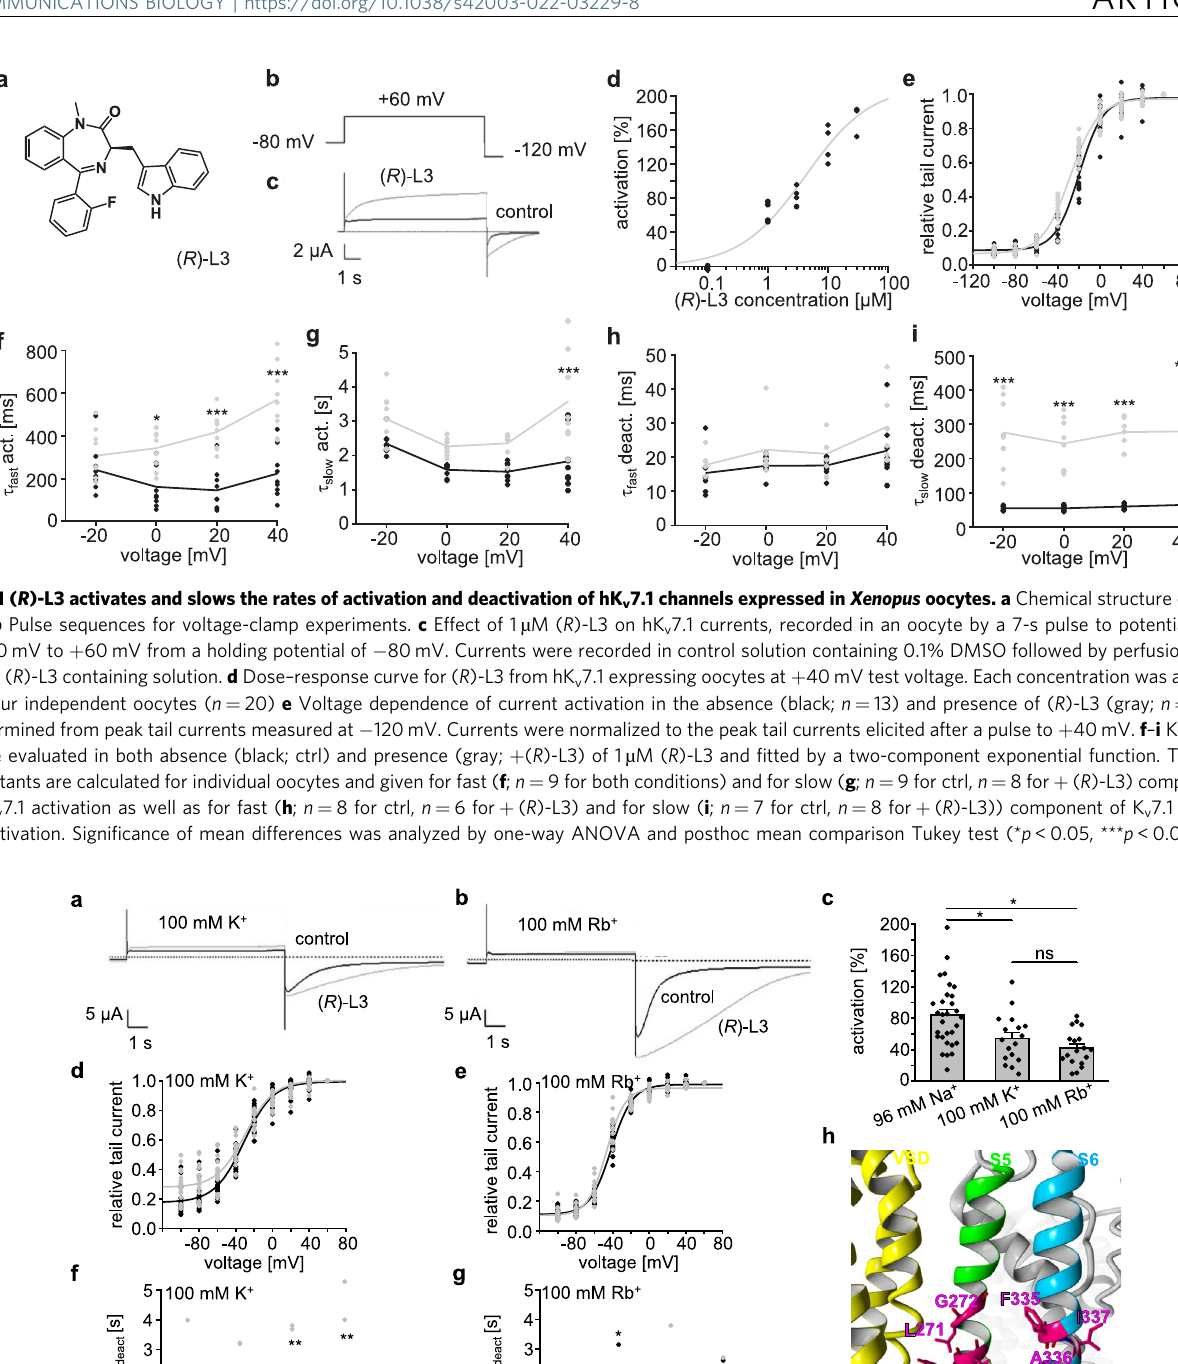
COMMUNICATIONS BIOLOGY| (2022) 5:301 |https://doi.org/10.1038/s42003-022-03229-8|www.nature.com/commsbio